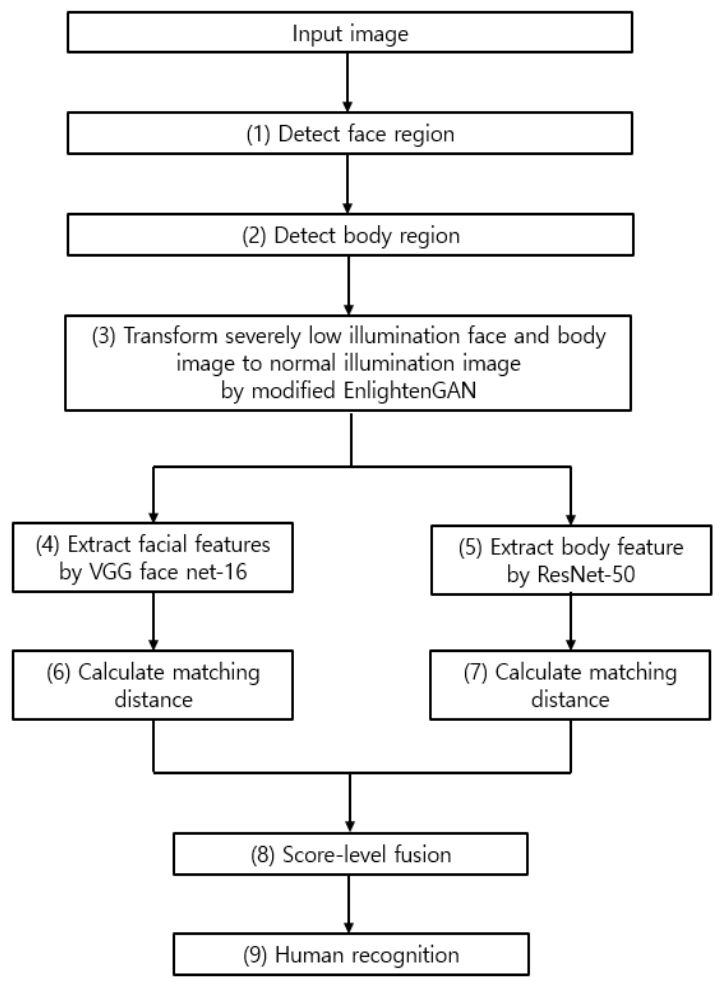
Figure 1. Overall procedure of proposed method.